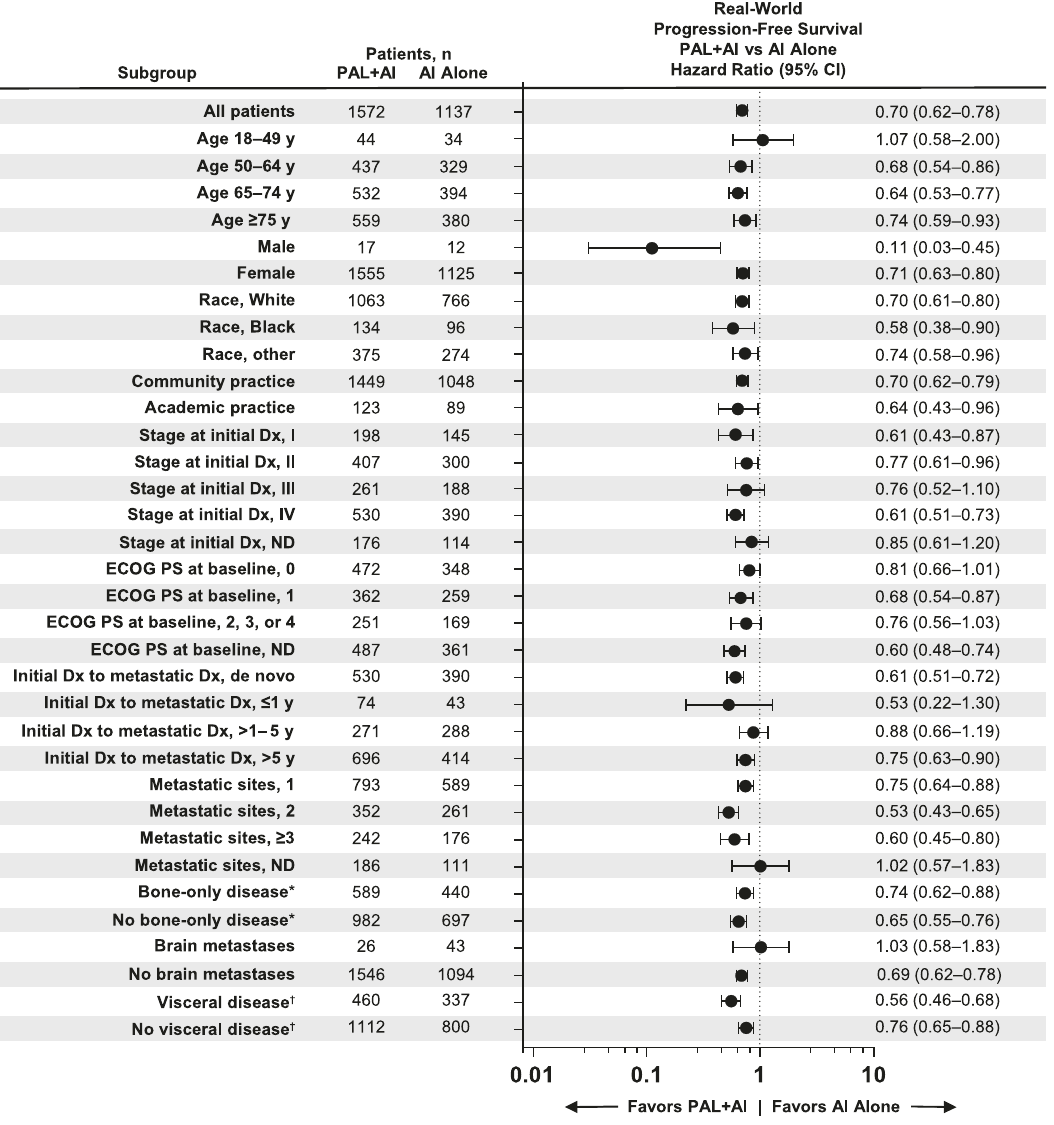
Fig. 6 Forest plot of real-world progression-free survival by subgroup after sIPTW. AI aromatase inhibitor; Dx diagnosis; ECOG PS Eastern Cooperative Oncology Group performance status; ND not documented; PAL palbociclib; sIPTW = stabilized inverse probability of treatment weighting. * Bone-only disease was de fi ned as metastatic disease in the bone only. † Visceral disease was de fi ned as metastatic disease in the lung and/or liver; patients could have had other sites of metastases. No visceral disease was de fi ned as no lung or liver